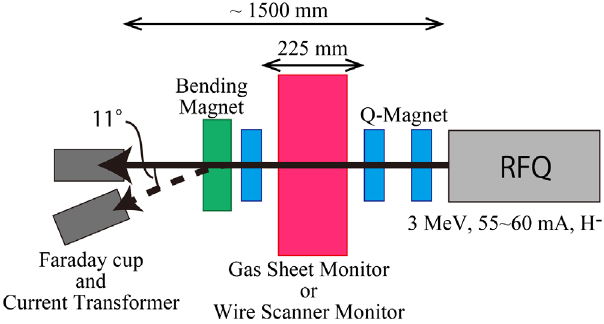
FIG. 6. The medium energy beam transport (MEBT) line test stand of the J-PARC Linac. The amount of the gas flux is limited to keep the gas pressure at the RFQ to be less than 5 × 10 − 5 Pa.